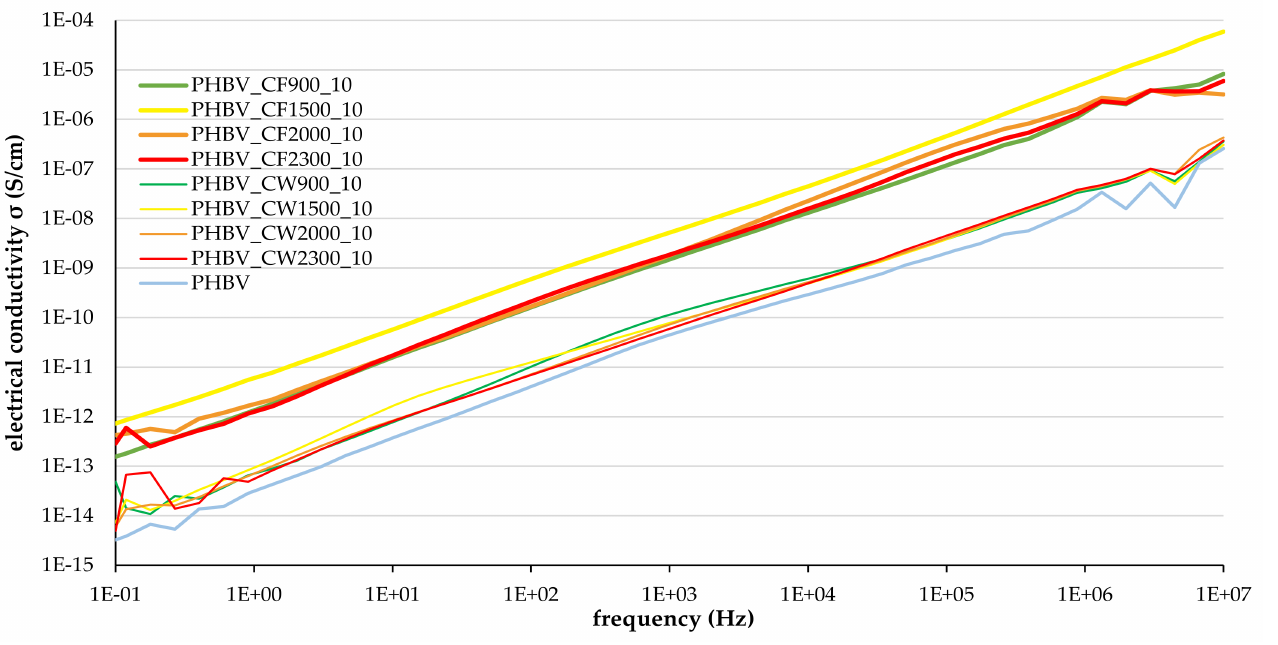
Figure 3. Electrical conductivity of PHBV composites in the measured frequency range. Impact of filler type (carbonized cellulose fibers (CF) or wood dust (CW)) and carbonization temperature (900–2300 ◦